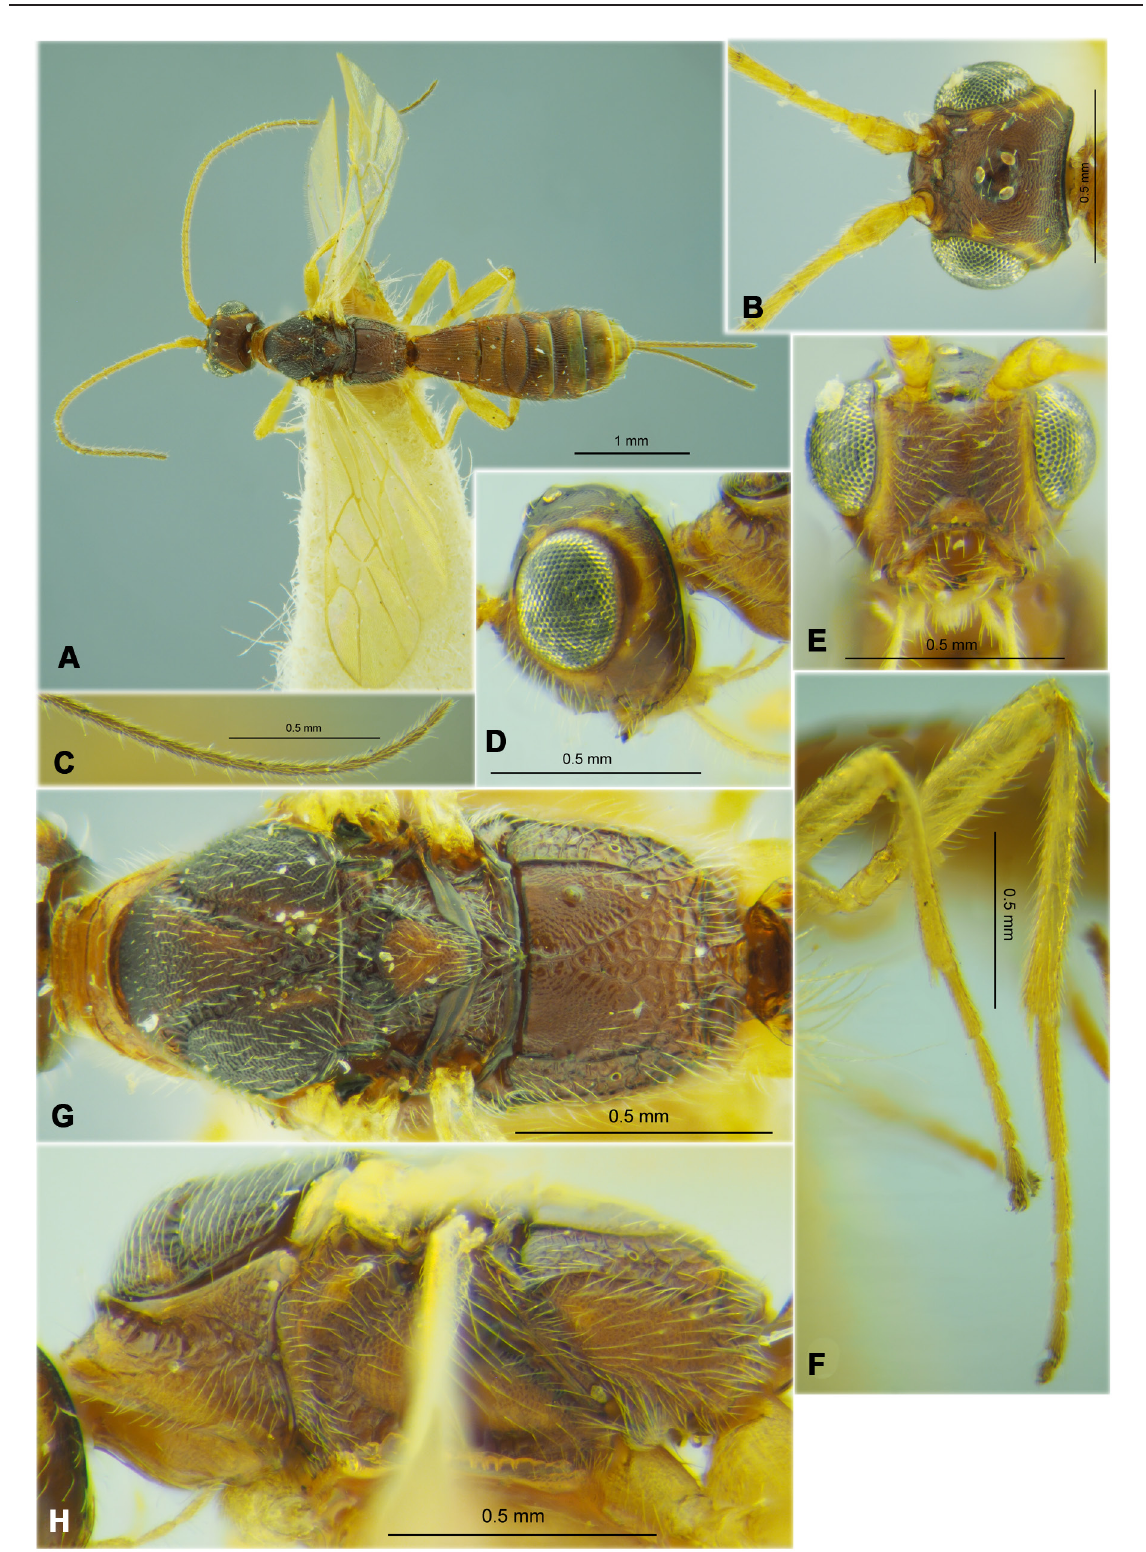
Fig. 45. Rhaconotinus ( Rh. ) menippus (Nixon, 1939), ♀ (RMNH). A . Habitus, lateral view. B . Head and basal segments of antenna, dorsal view. C . Apical segments of antenna. D . Head, lateral view. E . Head, front view. F . Hind leg. G . Mesosoma, dorsal view. H . Mesosoma, lateral